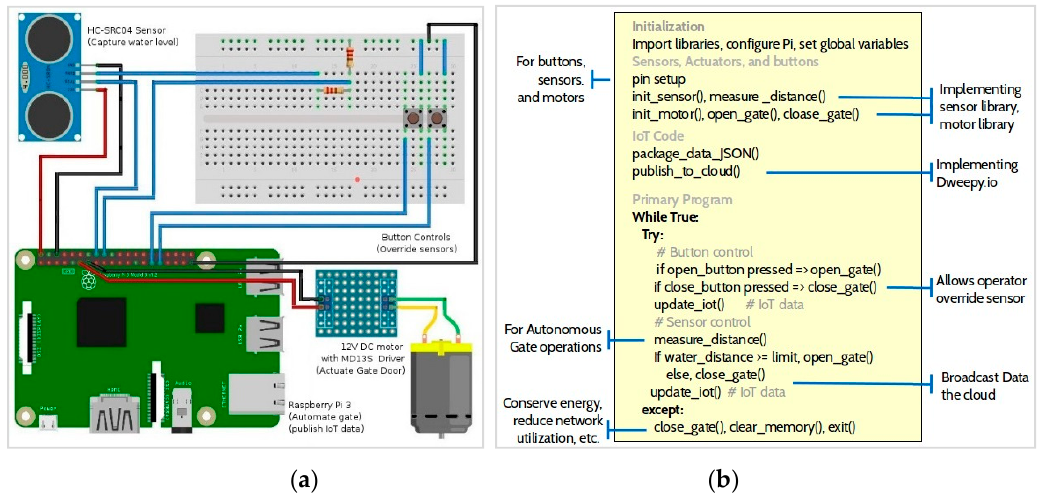
Figure 9. Setup for the Raspberry Pi controller, ( a ) setup of the hardware components, ( b ) Controller program algorithm.